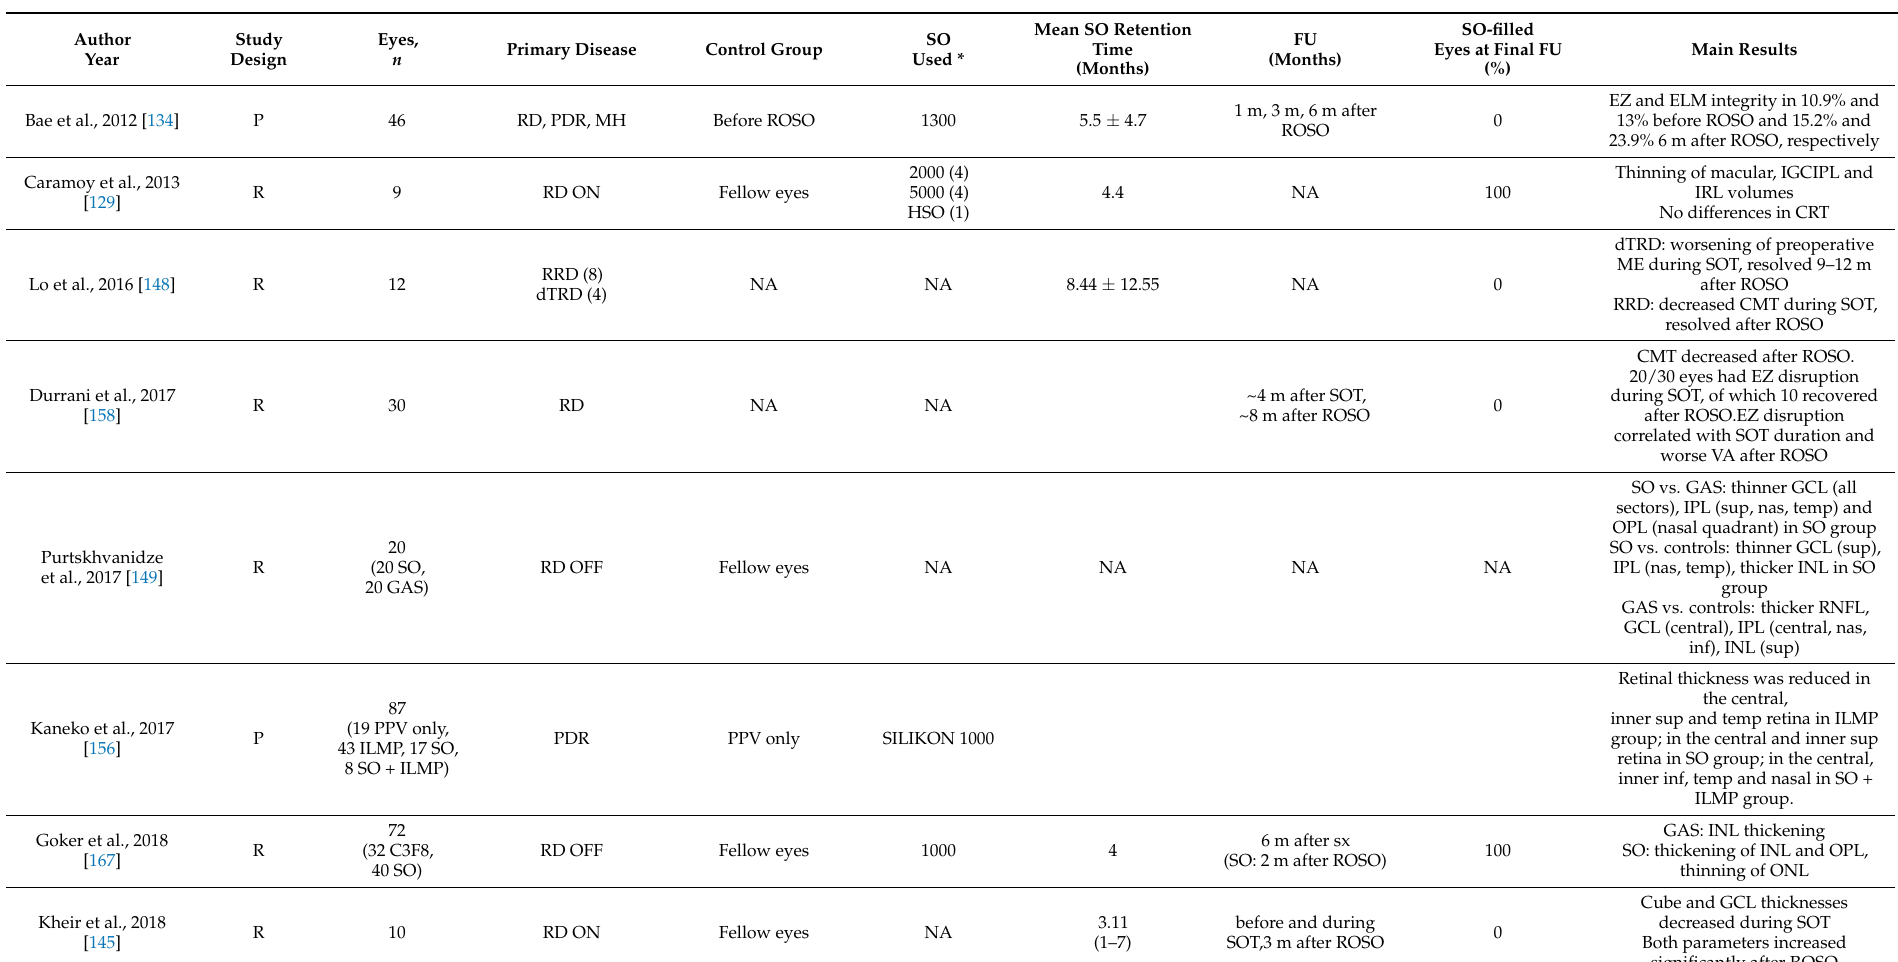
Table 3. Silicone oil-related changes of retinal layers